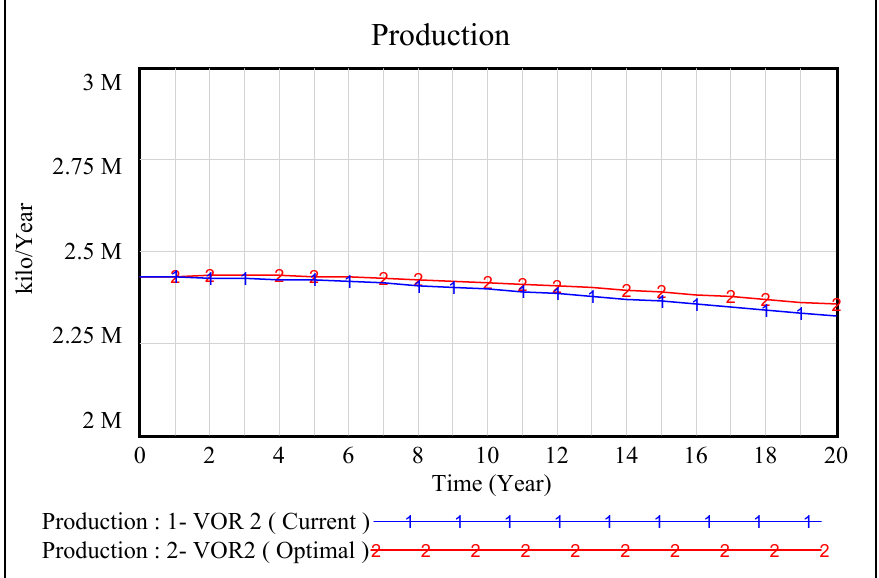
Figure 19. Comparison of the effect of the current and optimal amounts of the voluntary omission rate 2 on milk production.